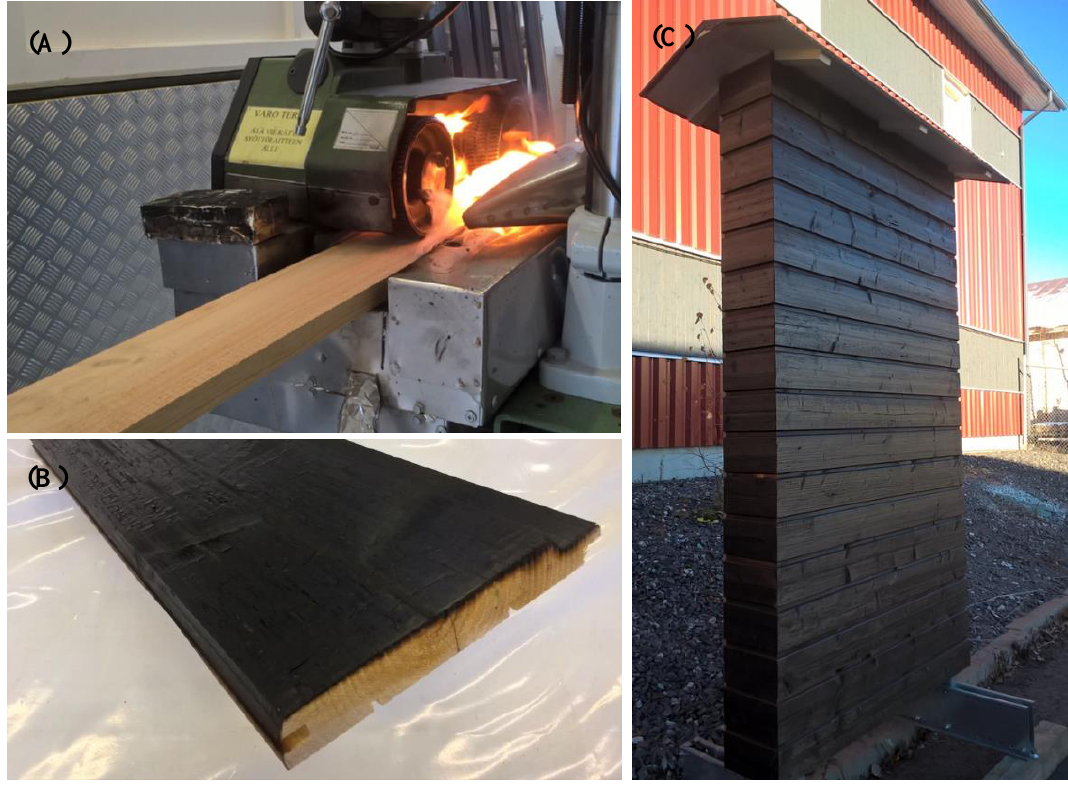
Figure 1. ( A ) The prototype charring device; ( B ) a charred spruce panel; ( C ) the experimental wall.